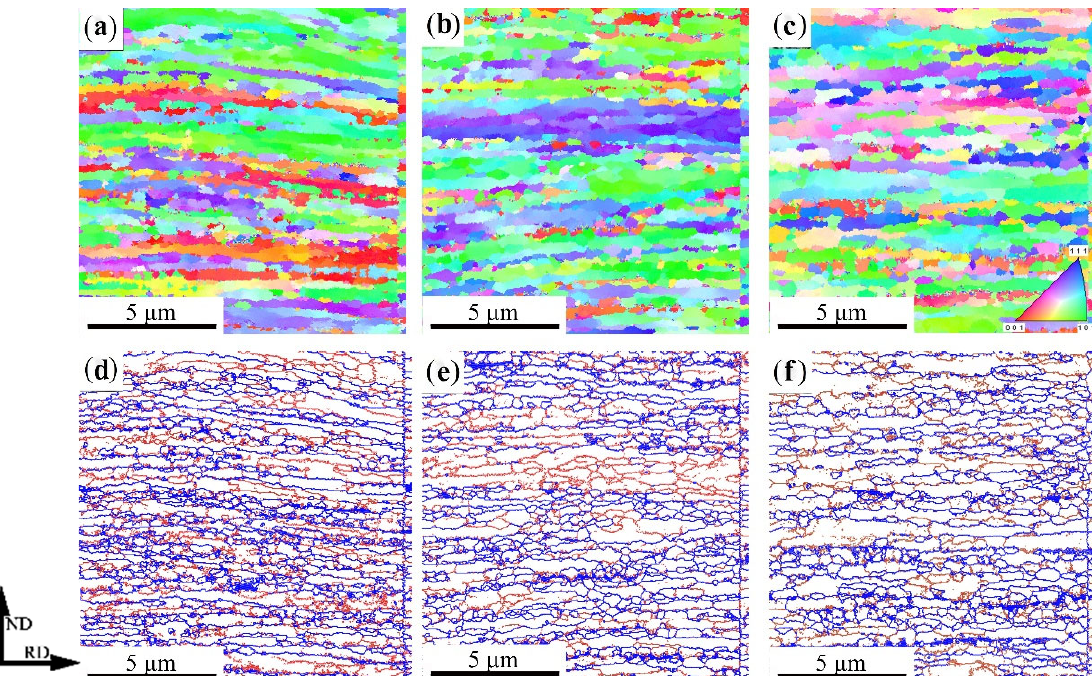
Figure 4. EBSD orientation map of ( a ) 500 °C, ( b ) 550 °C, and ( c ) 600 °C warm rolling samples and EBSD boundary map of ( d ) 500 °C, ( e ) 550 °C, and ( f ) 600 °C warm rolling samples.